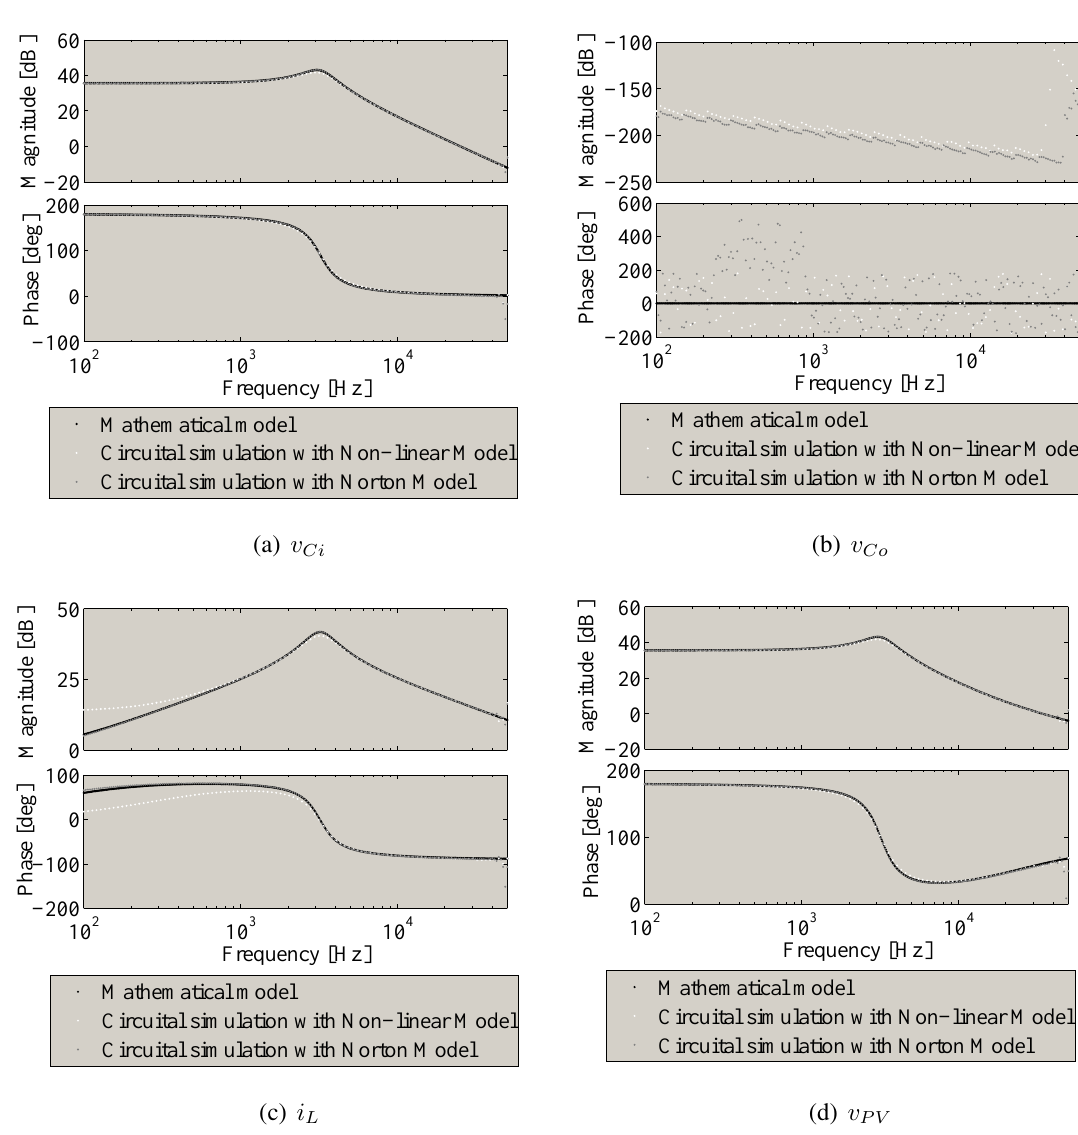
Figure 11. Model and circuit frequency responses: realistic converter with bulk voltage